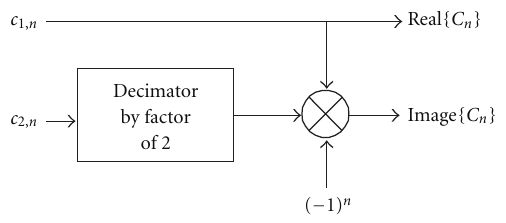
Figure 1: Block diagram of a method to form a complex spreading sequence from two bipolar sequences [4].